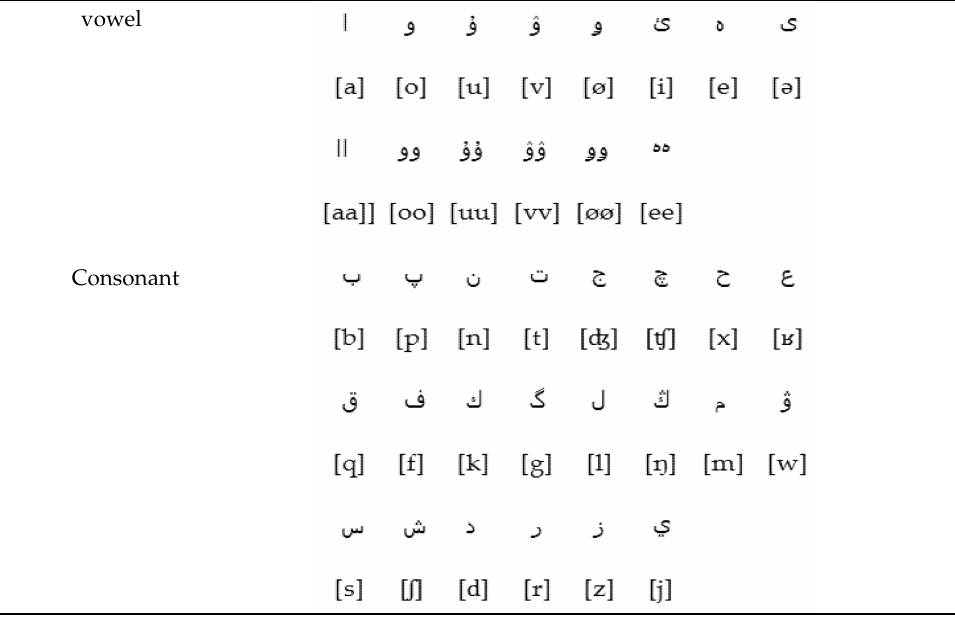
Table 1. The phonological system of Kirghiz